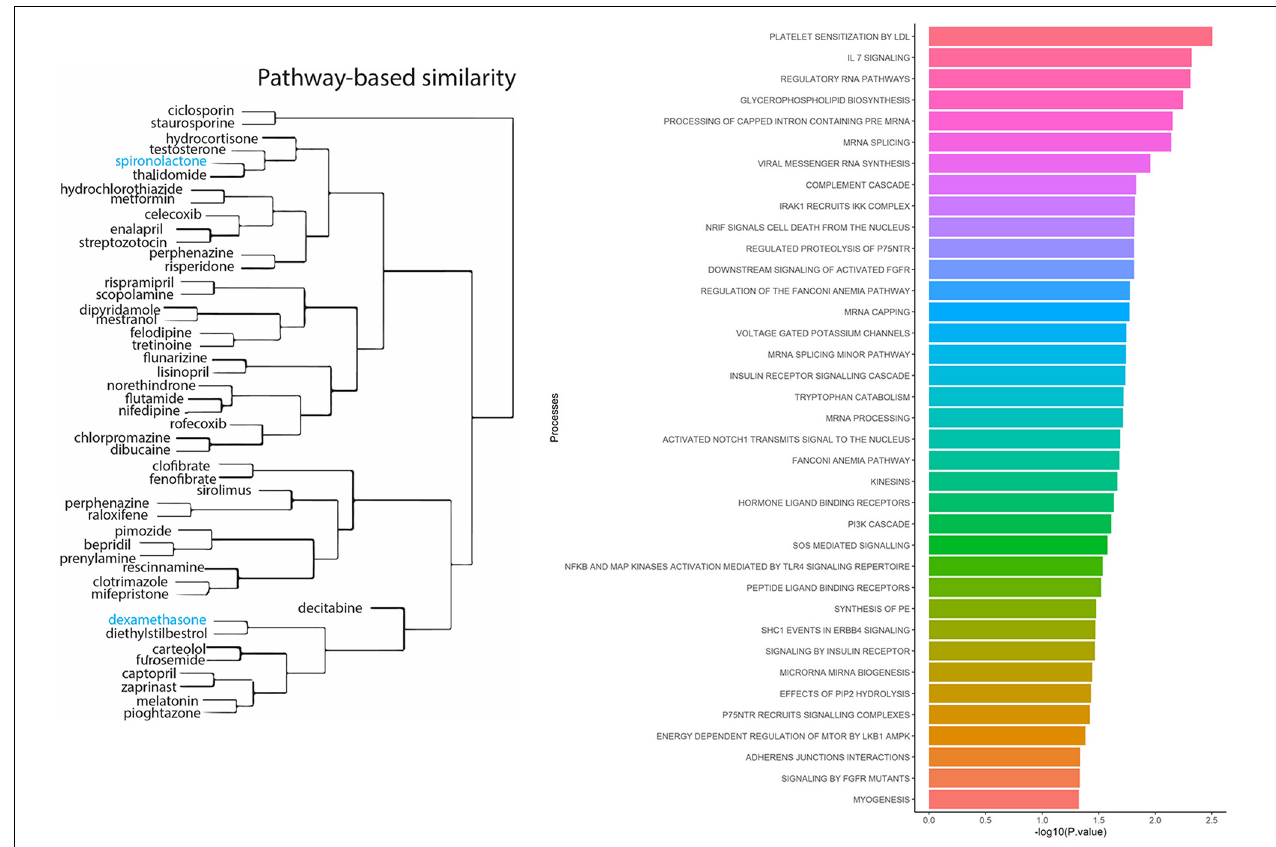
FIGURE 2 | Drug-set enrichment analysis. LEFT: The similarity of drugs based on pathways identified. RIGHT: Biological Processes identified based on drugs that interact with genes from the ACE2-network.